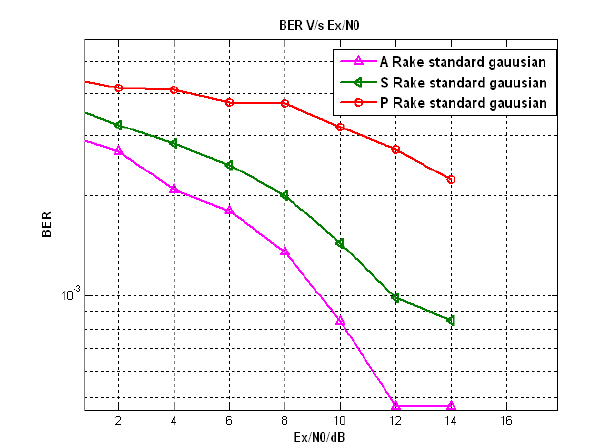
Fig.15. BER Analysis of System Model for the standard Gaussian fifth derivative using optimal coefficients